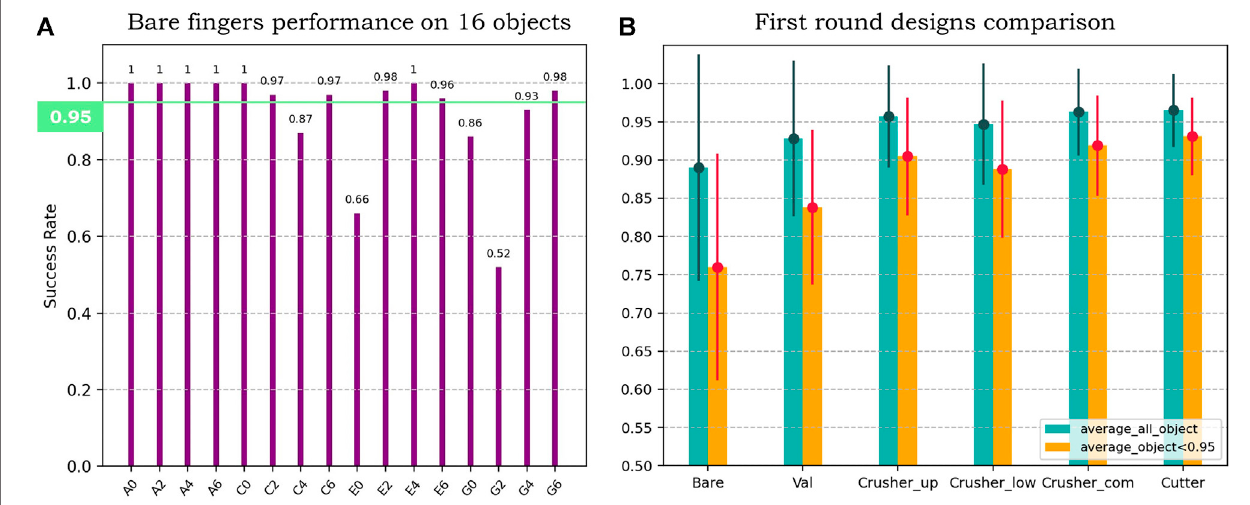
FIGURE 8 | (A) The grasping result of the bare fi ngers on all 16 objects, with 11 objects higher than 95%. (B) The grasping result of the fi rst round designs on the whole object set (green bars) and the shortlisted set (yellow bars), with mean and variance.